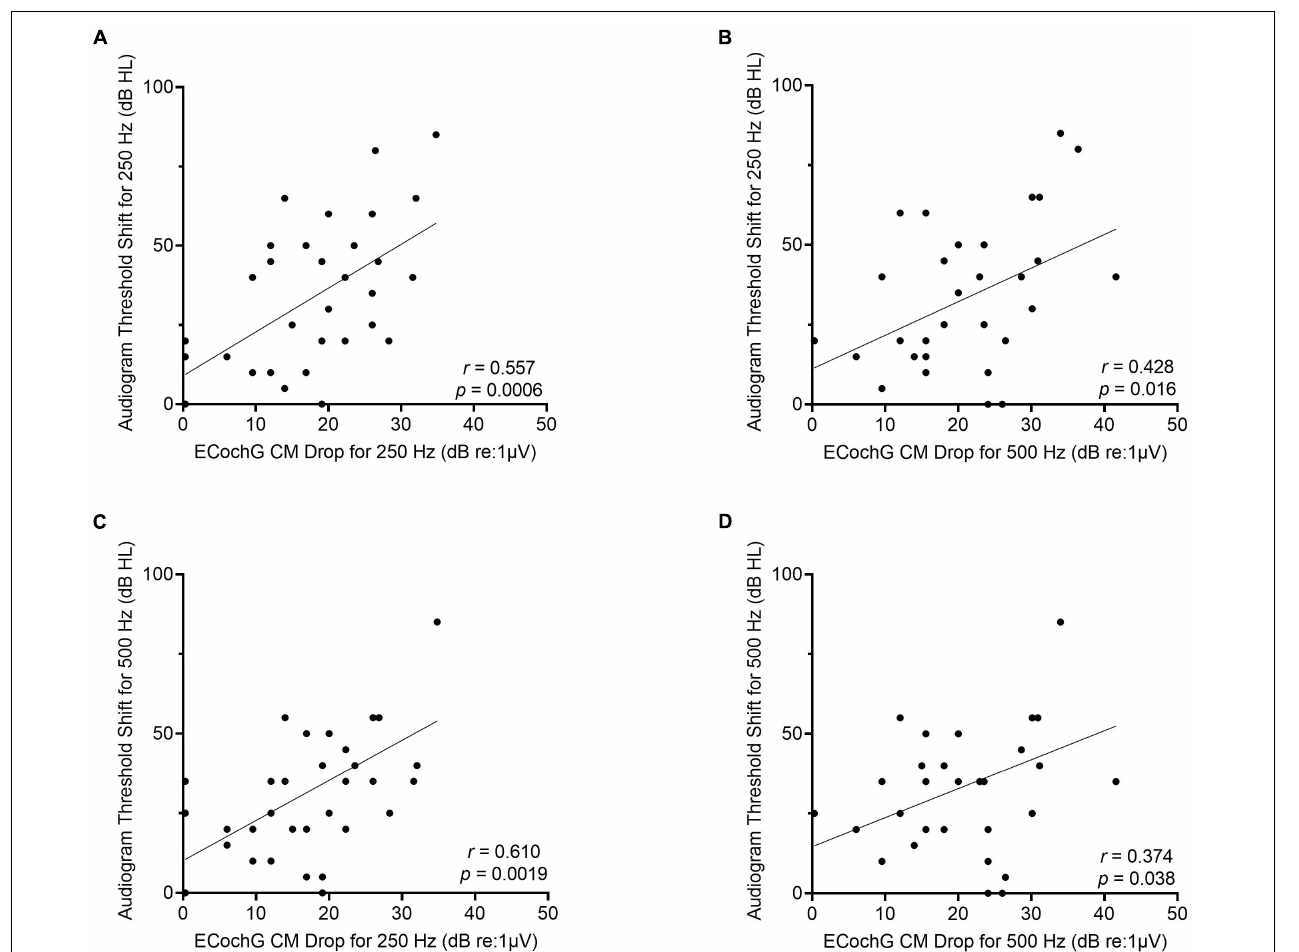
FIGURE 6 | For the perimodiolar electrode, changes in ECochG CM drops for 250-Hz are more strongly correlated with frequency-specific audiogram threshold shift at both 250- and 500-Hz compared to ECochG CM drops when using 500-Hz stimulus. (A) Moderately strong linear correlation between audiogram threshold shift at 250-Hz from preoperative to 1-month post-activation and largest ECochG CM drop for 250-Hz. (B) Moderately strong linear correlation between audiogram threshold shift at 250-Hz and largest ECochG CM drop for 500-Hz. (C) Moderately strong linear correlation between audiogram threshold shift at 500-Hz and largest ECochG CM drop for 250-Hz. (D) Weak linear correlation between audiogram threshold shift at 500-Hz and largest ECochG CM drop for